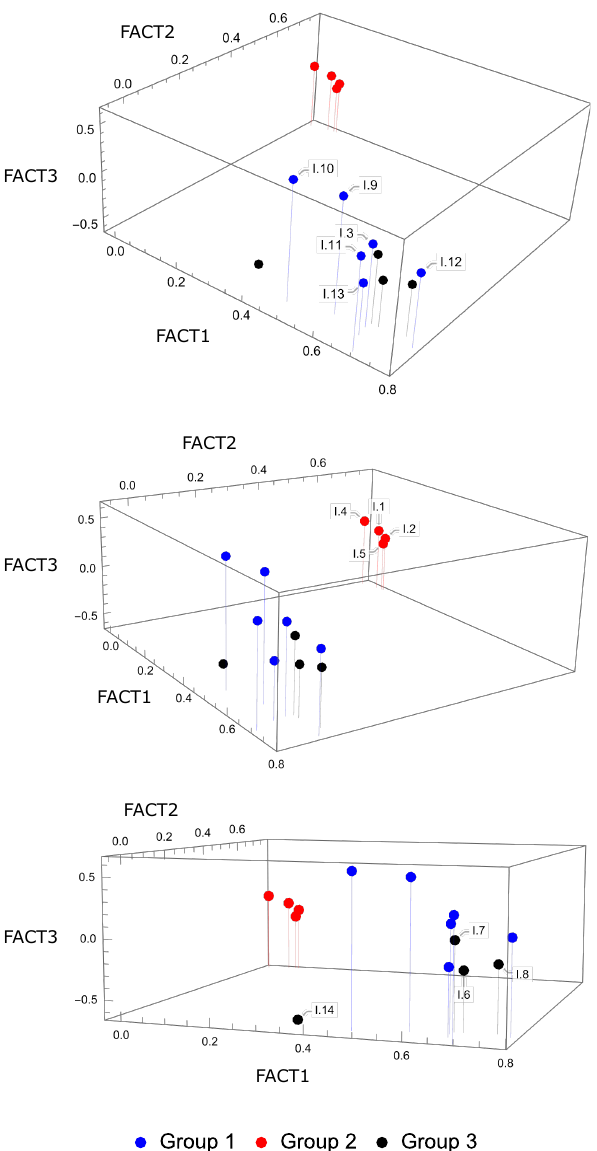
Figure 4. WhatsApp items space on three factors for Indian data in three different